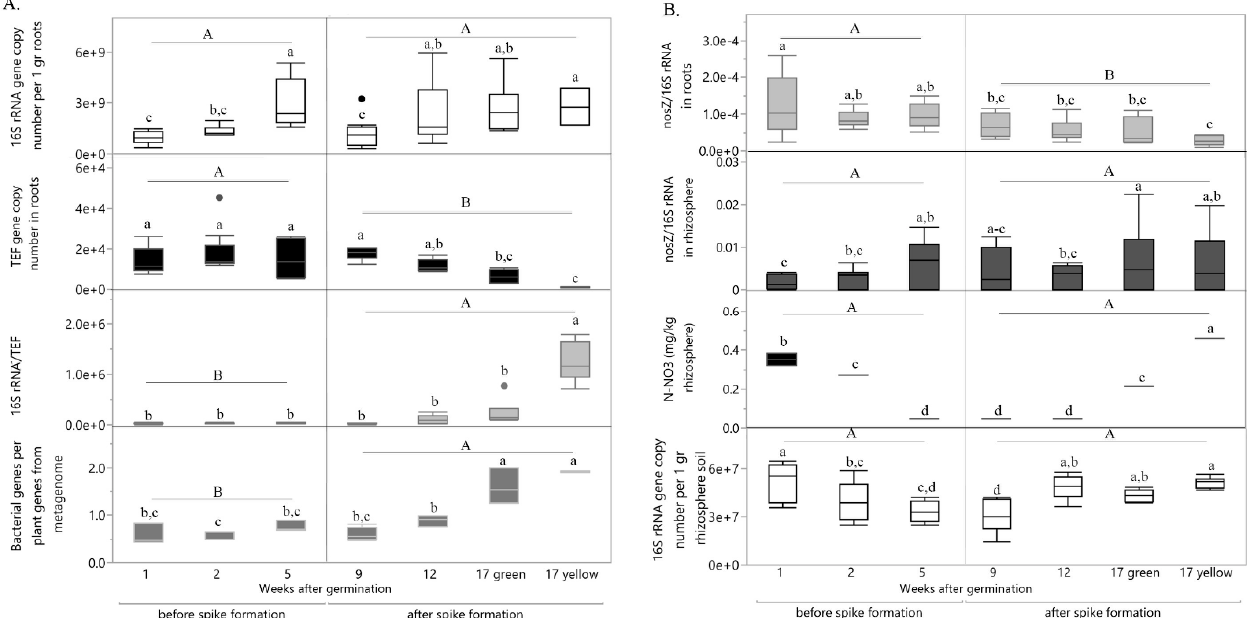
Figure 2. Influence of wheat developmental stage on total bacterial community and nosZ gene abundance in roots and rhizosphere. ( A ) Changes in abundance of total bacterial community (16S rRNA) and its relative abundance per root tissue (e.g., per the plant housekeeping gene TEF , and per total plant genes from metagenome) during wheat growth. ( B ) Changes in relative abundance of denitrifying gene nosZ per total bacterial community in roots and rhizosphere as well as nitrate content in rhizosphere during wheat growth. Each bar represents the average of three biological each of three technical replicates with standard error. Different uppercase and lowercase letters indicate significant difference ( p ≤ 0.05) by Student’s t test. N-NO 3 = nitrate nitrogen.